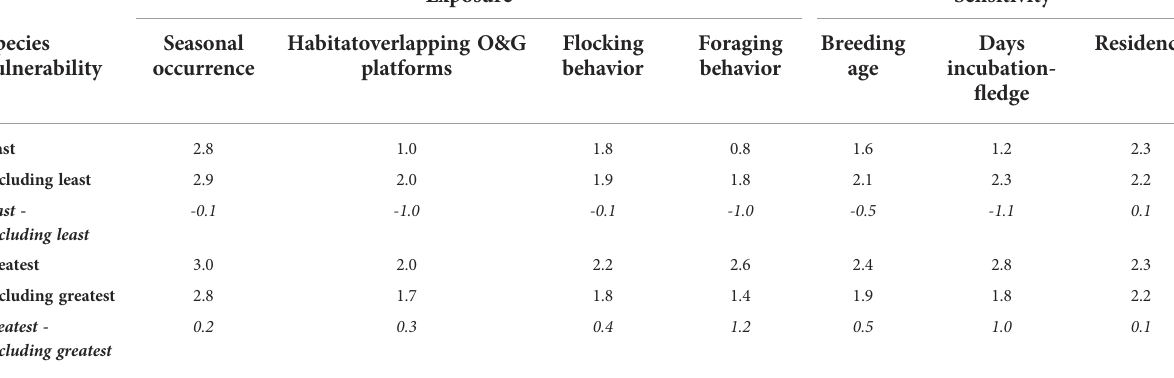
TABLE 3 The difference in the average score of each variable for the fi ve species with either the least or greatest vulnerability of seabirds to oiling compared to the remaining 19 species in the northern Gulf of